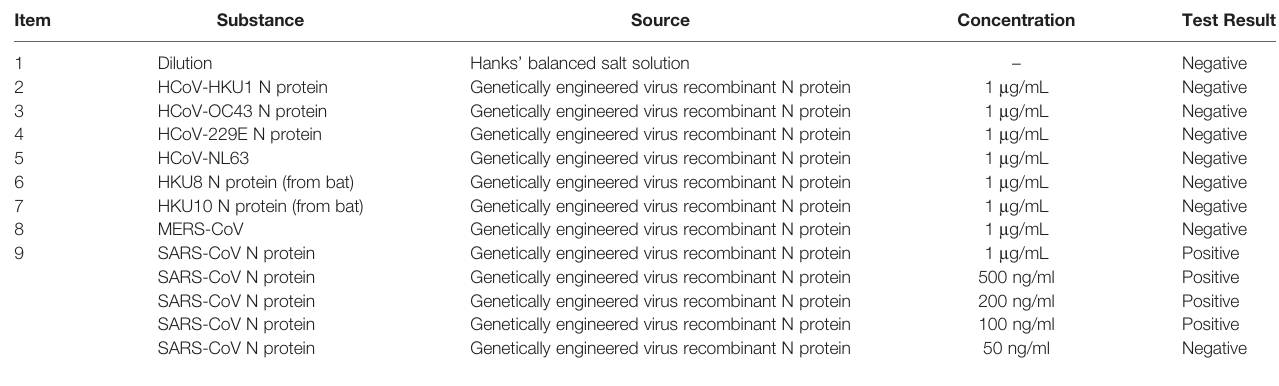
TABLE 3 | Results of different pathogen